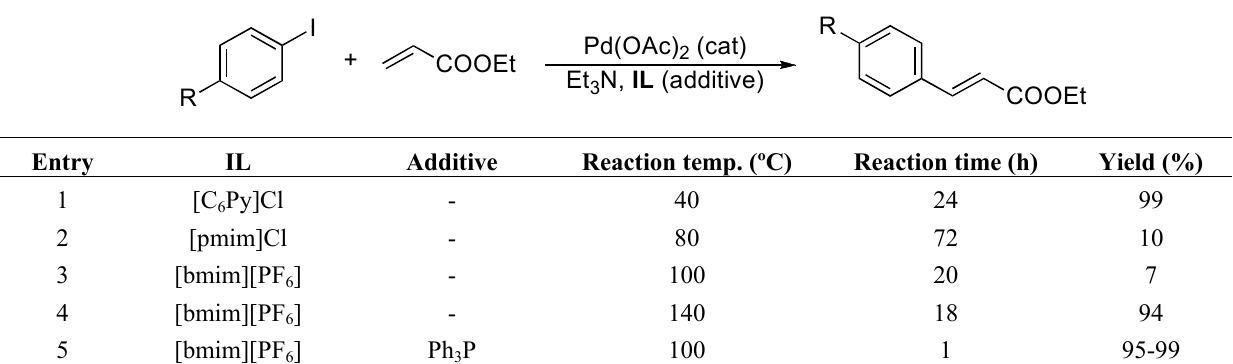
Table 3. Heck reaction in imidazole-based ILs.